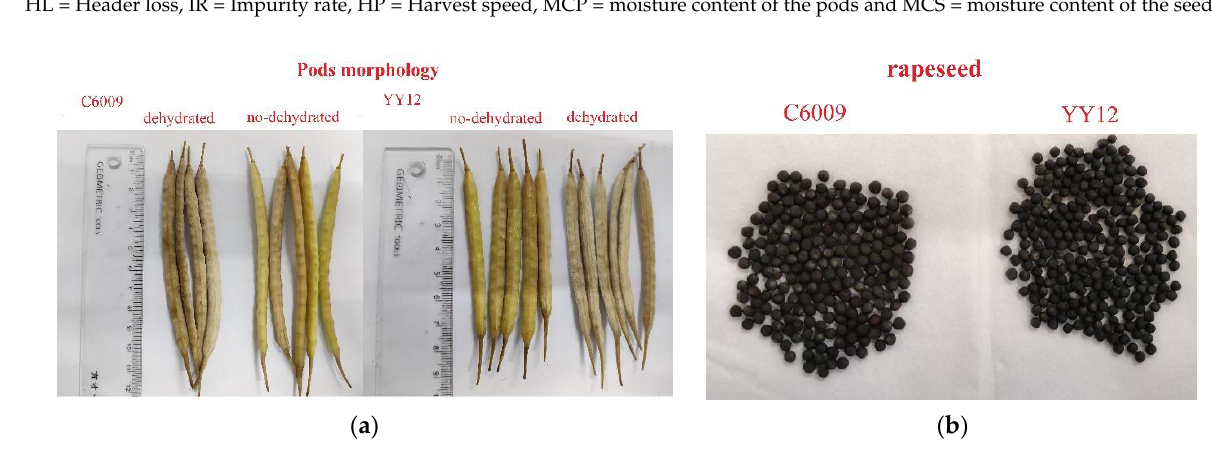
HL = Header loss, IR = Impurity rate, HP = Harvest speed, MCP = moisture content of the pods and MCS = moisture content of the seeds.